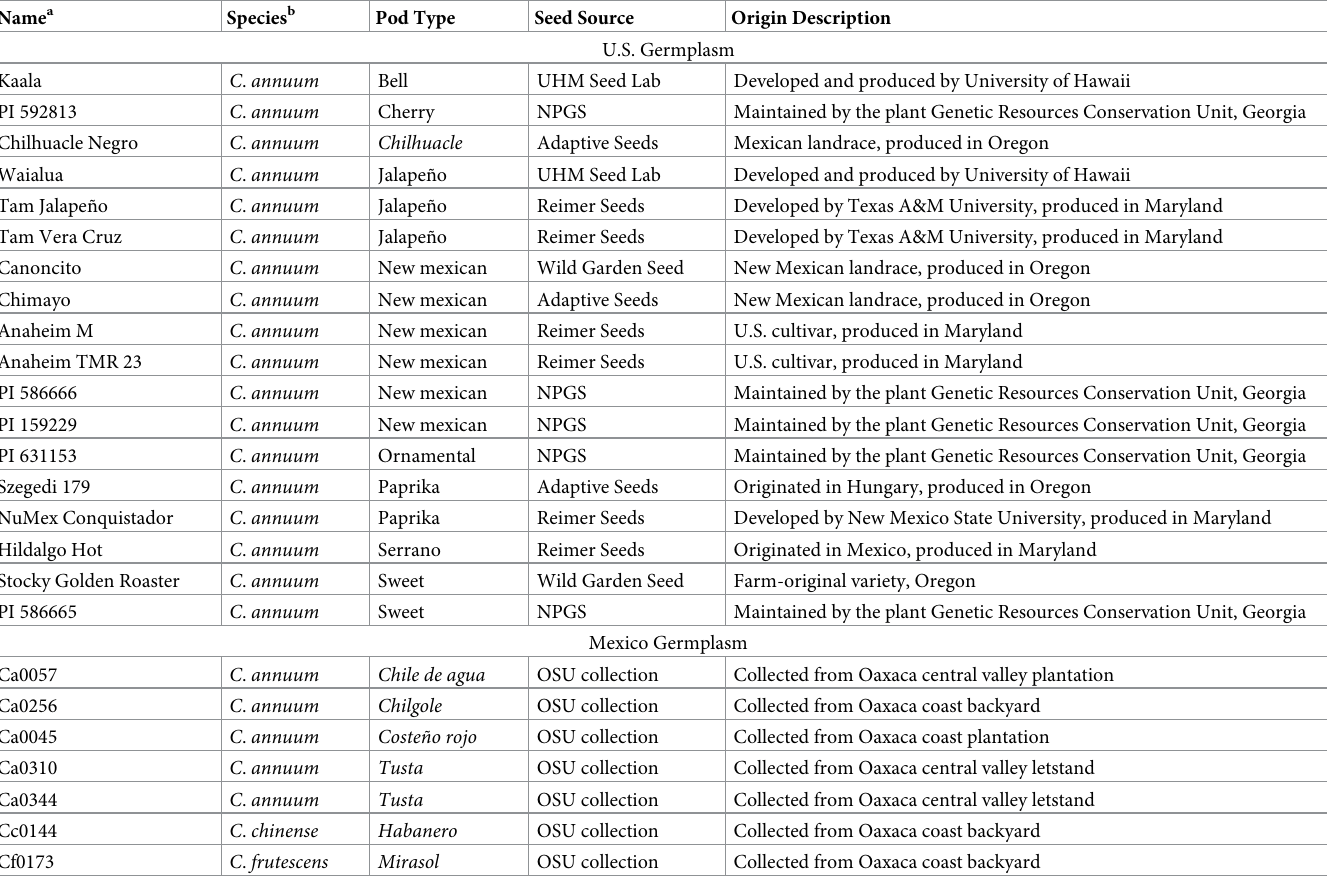
Table 1. List of germplasm used in a greenhouse soil water deficit experiment on chile pepper at the Ohio State University. Accessions are organized by country of origin. Name